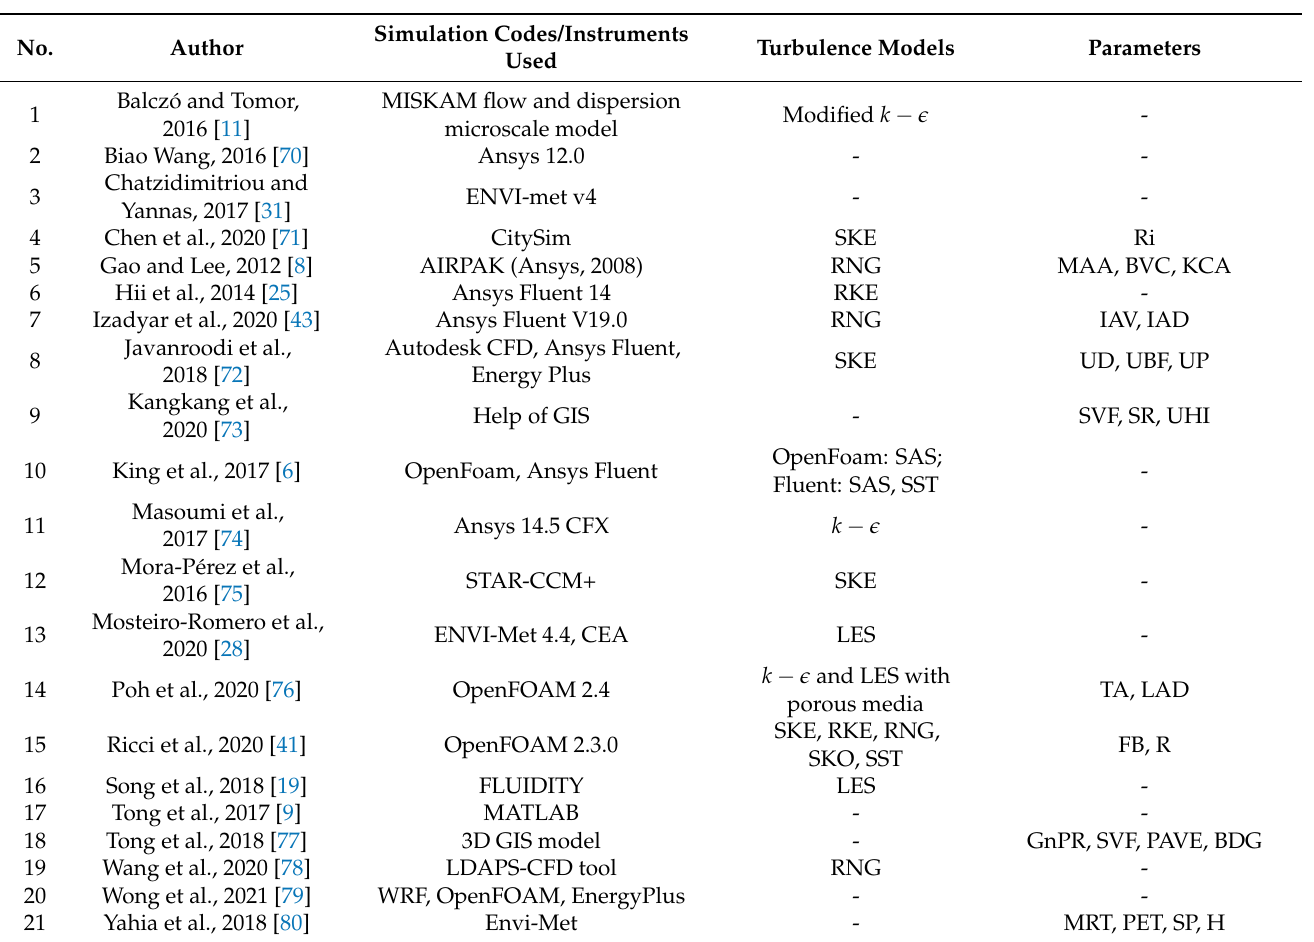
Table 6. Overview of studies of real urban areas with validation comparison with experimental or numerical data: adopted simulation codes, turbulence models and parameters.